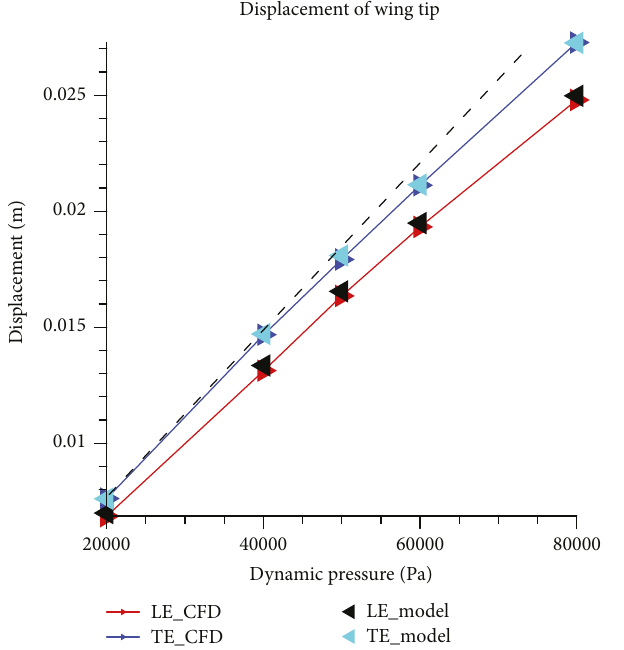
Figure 10: The displacement of the wing tip (dashed linear line is showed as reference).